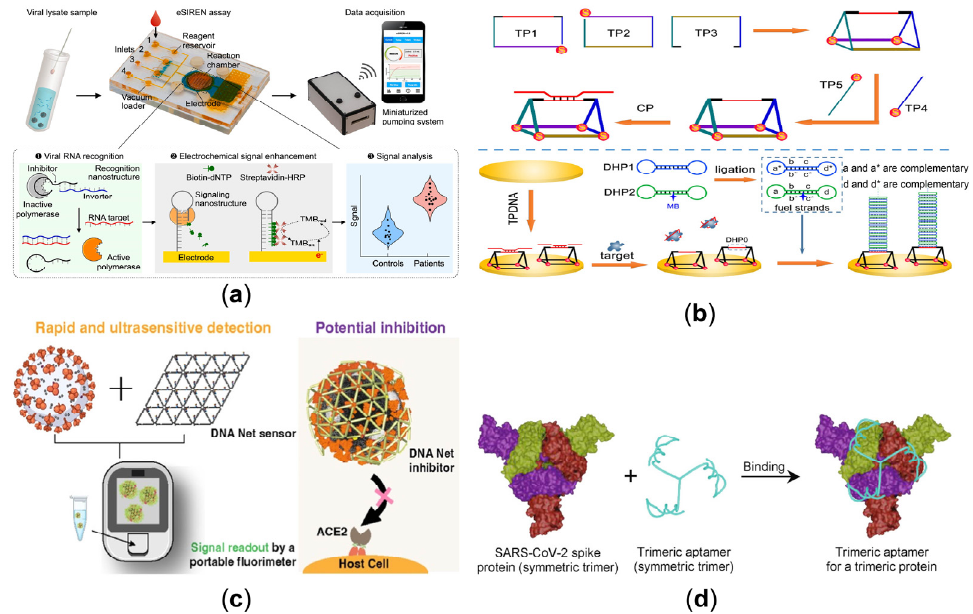
Figure 3. ( a ) Molecular nanostructures with electrochemical signal enhancement to detect SARS